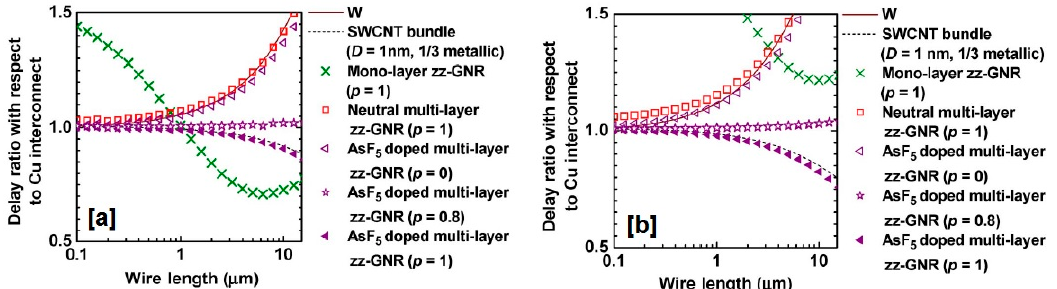
Figure 20. EDP of Cu and MLGNR interconnects as a function of interconnect length [7]. Reproduced with permission from [7]. IEEE, 2012.